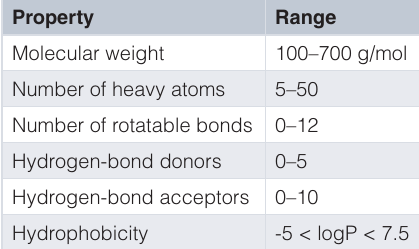
Table 1. Property filters for in silico post- processing of primary HTS data. These filters are used in Workflow 1.